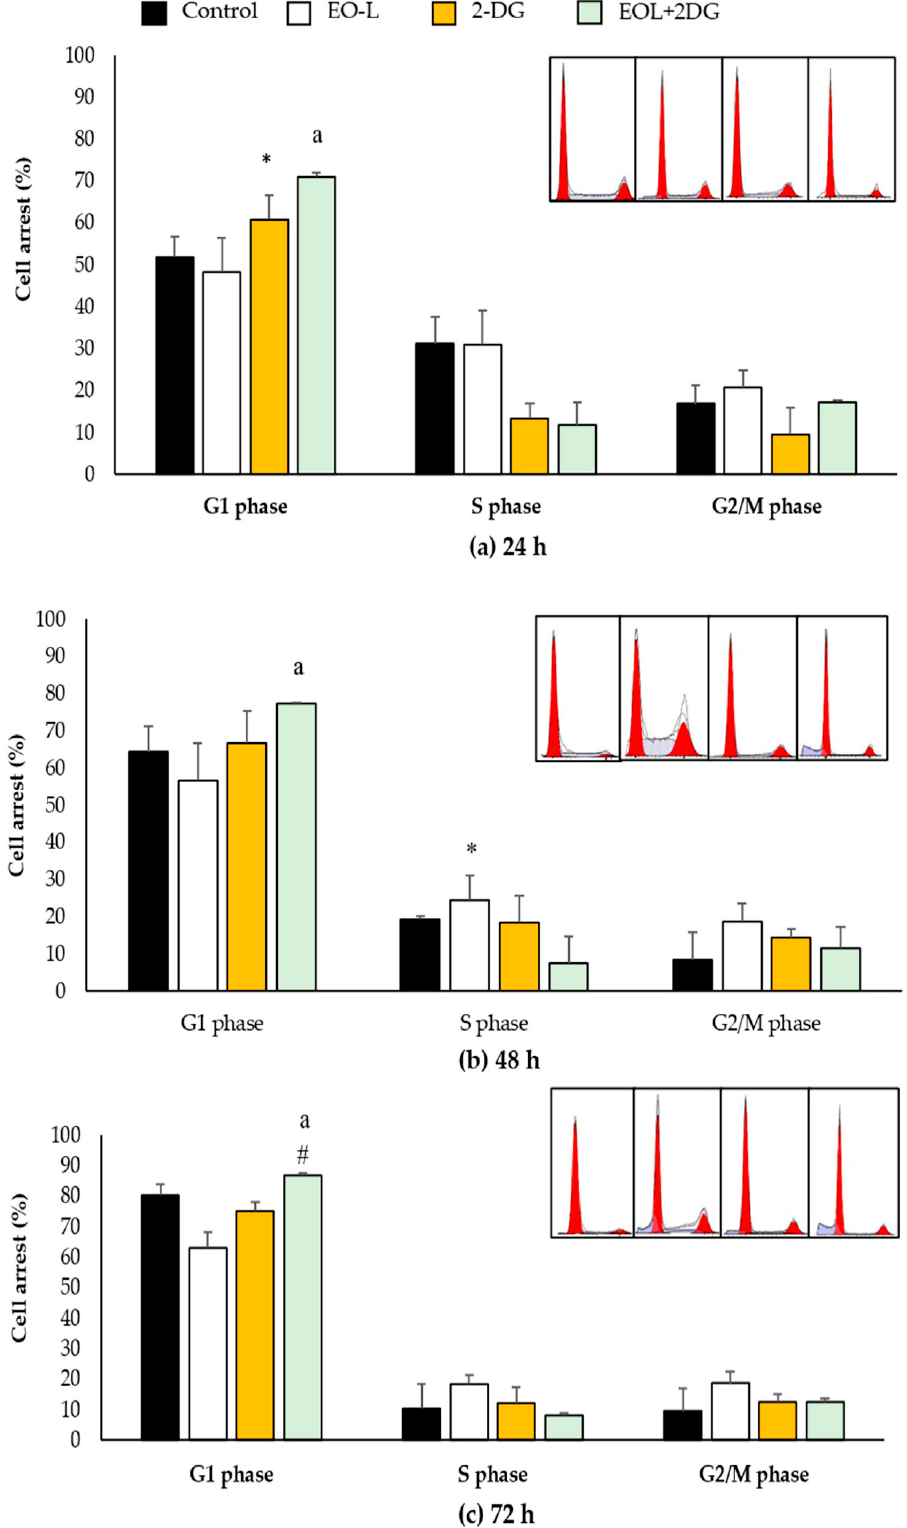
Figure 12. Induction of cell cycle arrest in PANC-1 cells. The percentages of cells in G1, S and G2/M phases were analyzed by flow cytometry after ( a ) 24 h, ( b ) 48 h and ( c ) 72 h. The data were shown as the mean values ± S.D. for three independent experiments, and the statistical analysis was determined using a Student’s t -test, with the * symbol showing a significant difference ( p < 0.05) in comparison to control untreated cells, the # symbol showing a significant difference ( p < 0.05) in comparison to 2-DG and the a symbol showing a significant difference ( p < 0.05) in comparison to EO-L.